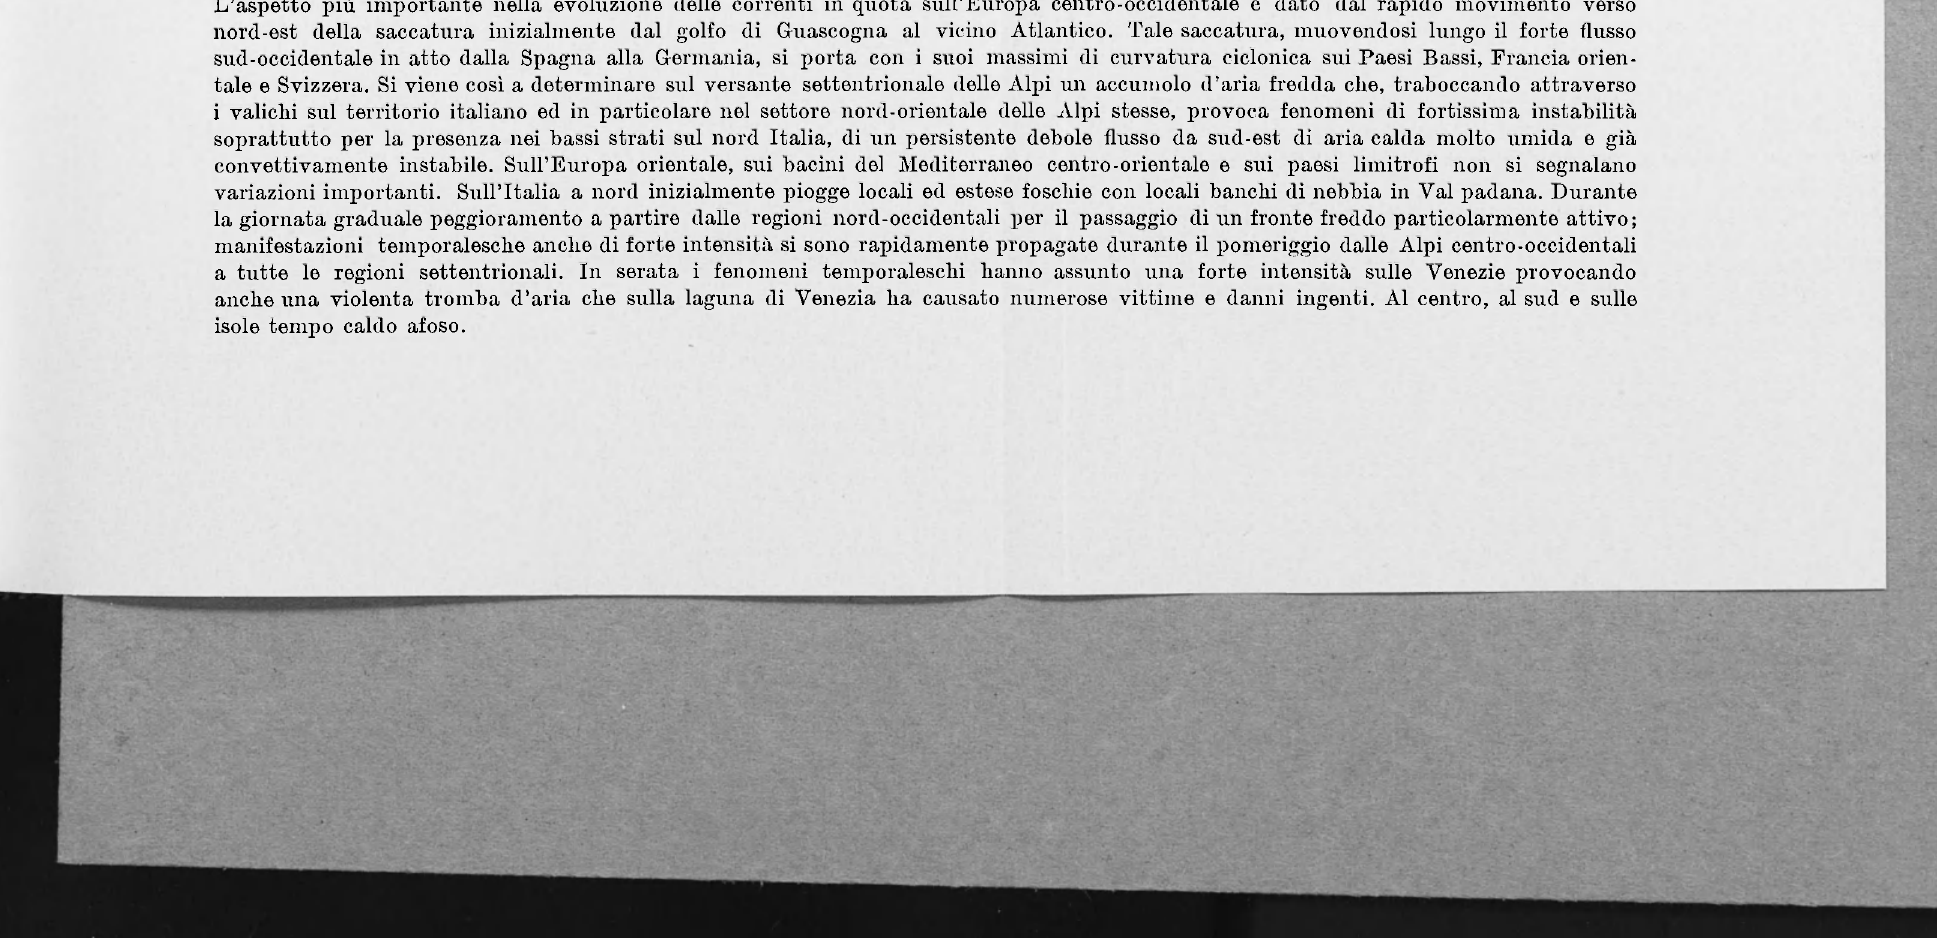
Fig. 7a - Evoluzione generale del tempo e tempo sull'Italia 1*11 Settembre 1970 (dal «Bollettino Meteorologico Quotidiano dell'Aeronautica Militare Italiana